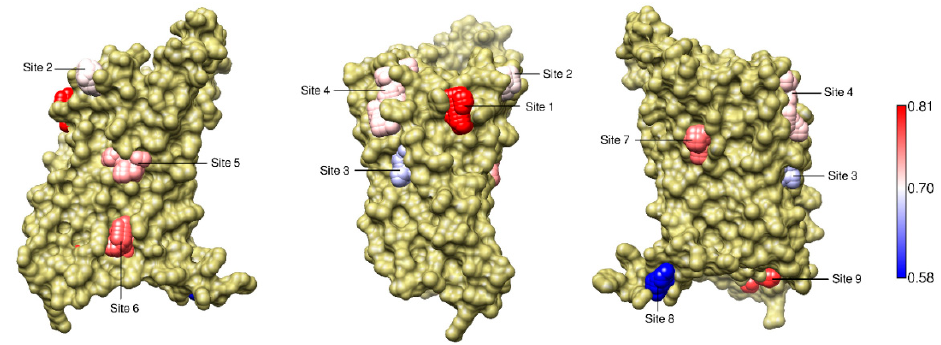
Figure 7. GCGR sites couplings to ∆ . Sites on the surface of GCGR are represented by spheres, that are colored according to C site , the coupling strength (from blue, denoting weaker coupling, to red, indicating stronger coupling). Sites 5 and 6 correspond to known allosteric sites (see Figure 1d).